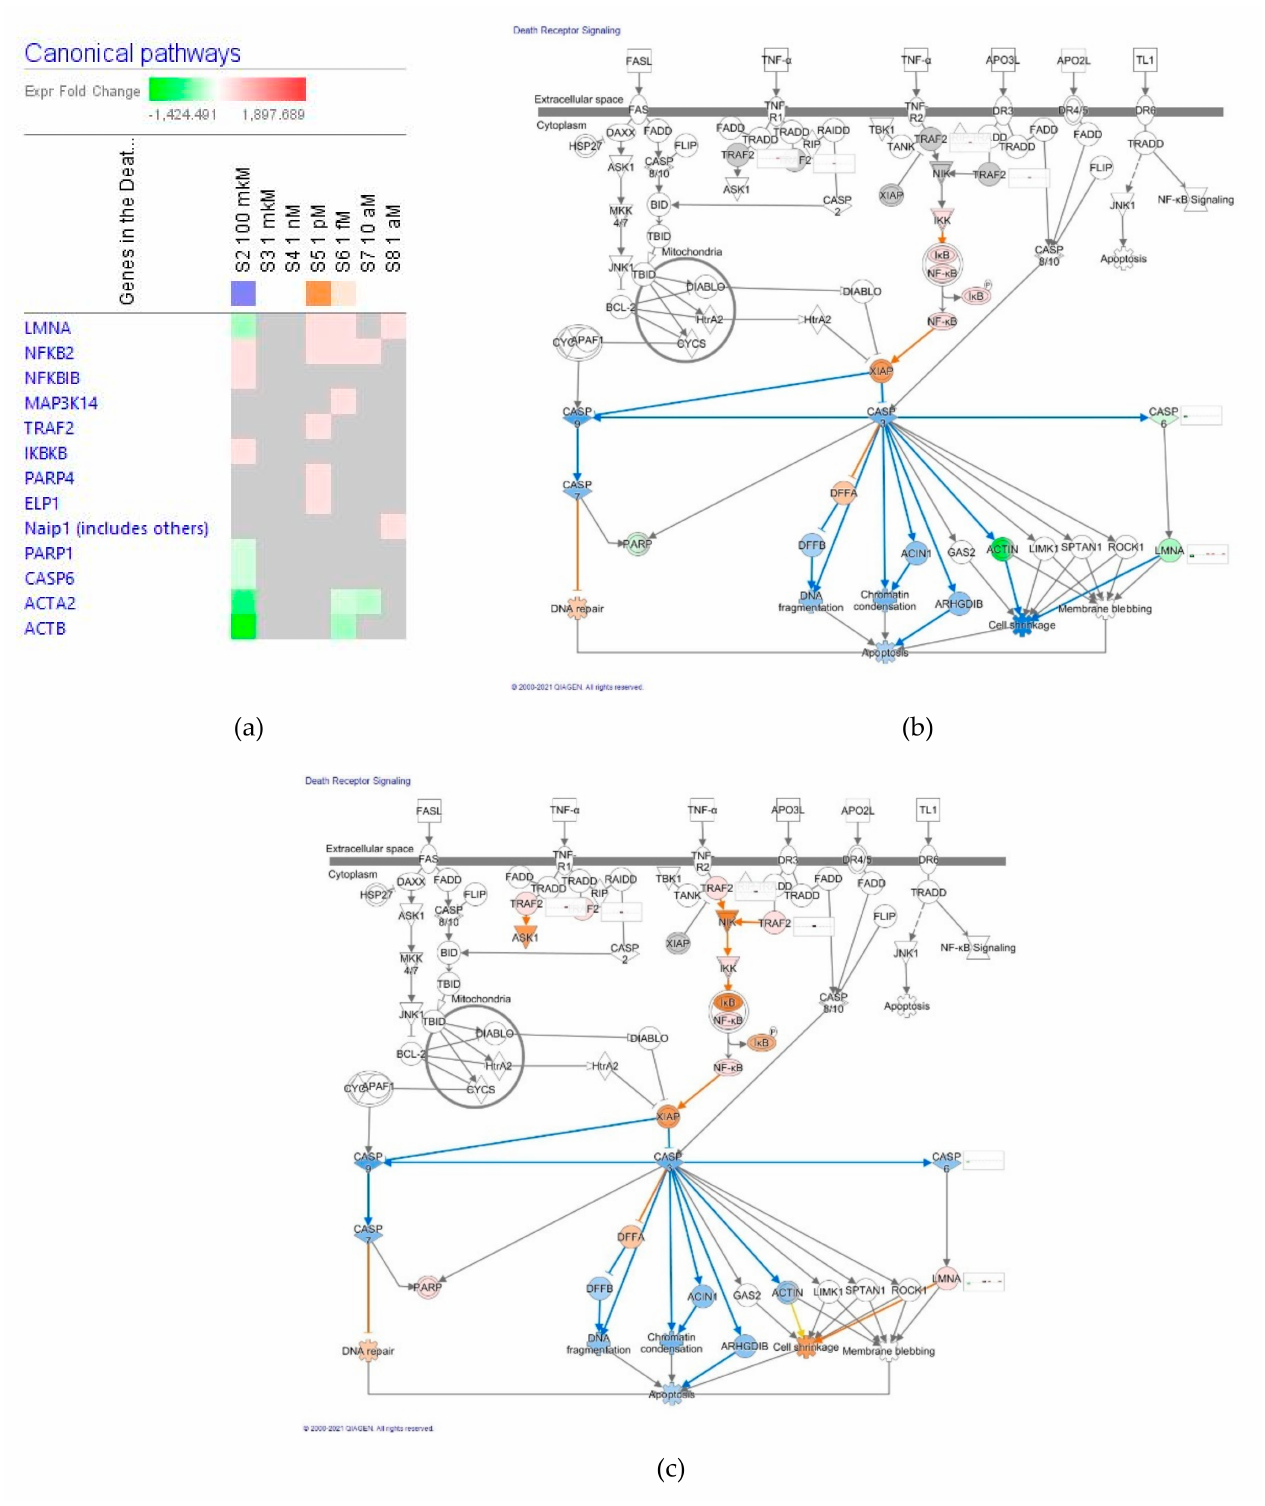
Figure 12. Effect of Rg5 on death receptors signaling pathway: ( a ) Heatmap of gene expression (in fold changes compared to control, red, upregulation and green, downregulation), after exposure with ginsenoside Rg5 at different concentrations; the 100 µ M signature is shown in the leftmost column as solid red or green squares indicating genes that are upregulated or downregulated, respectively; color intensity indicates the actual log-fold changes; ( b ) Rg5 at a concentration of 100 µ M— predicted inhibition (blue) and activation (brown); ( c ) Rg5 at a concentration of 1 µ M—predicted inhibition (blue) and activation